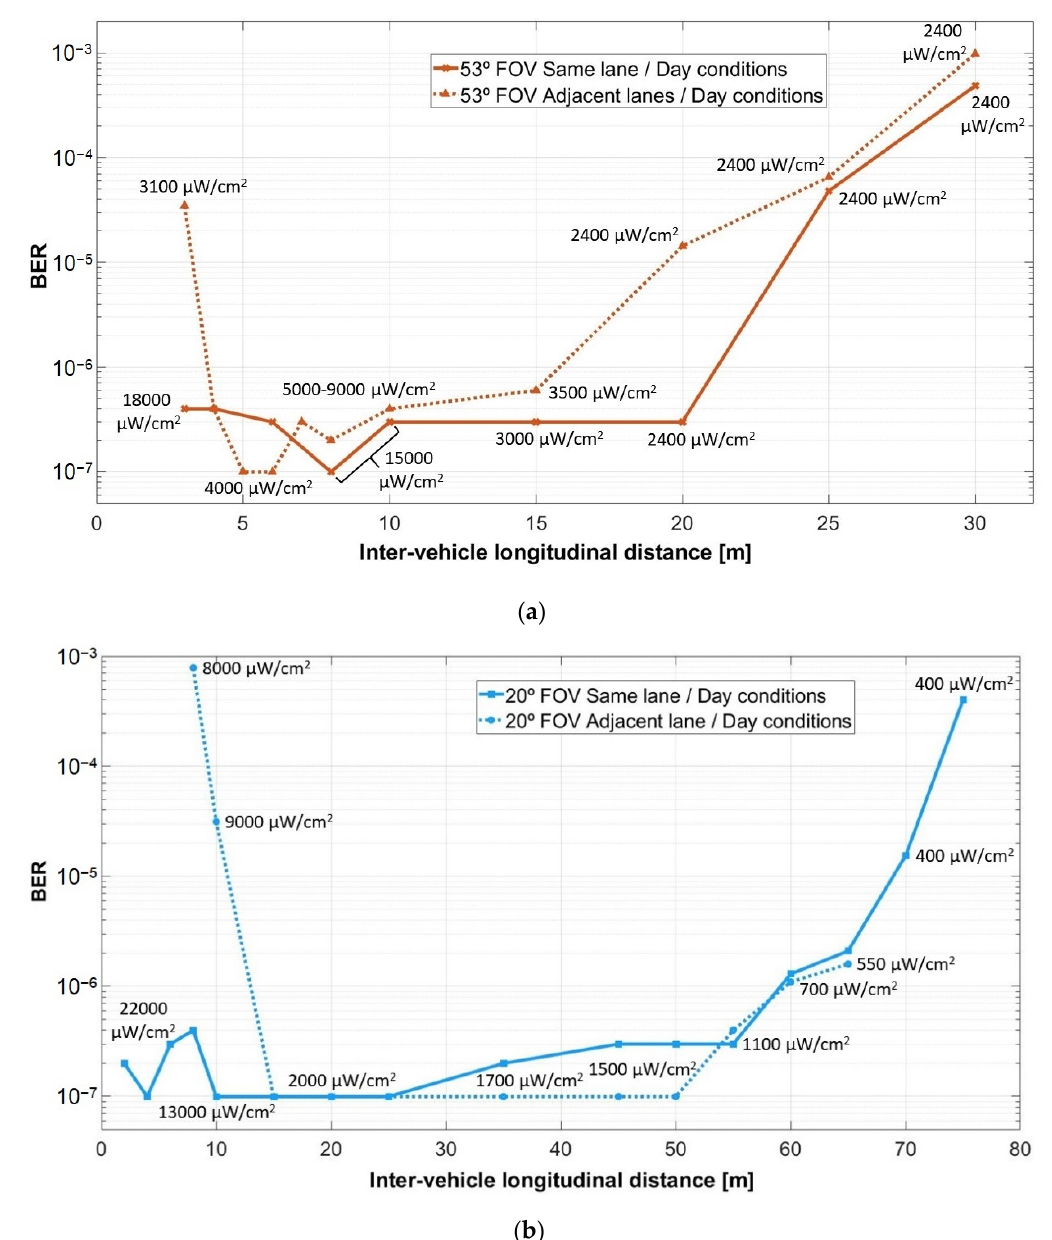
Figure 12. Experimental BER results for the evaluation of the vehicle-to-vehicle VLC link in uncontrolled day conditions: ( a ) for a ±53° reception angle; ( b ) for a ±20° reception angle.